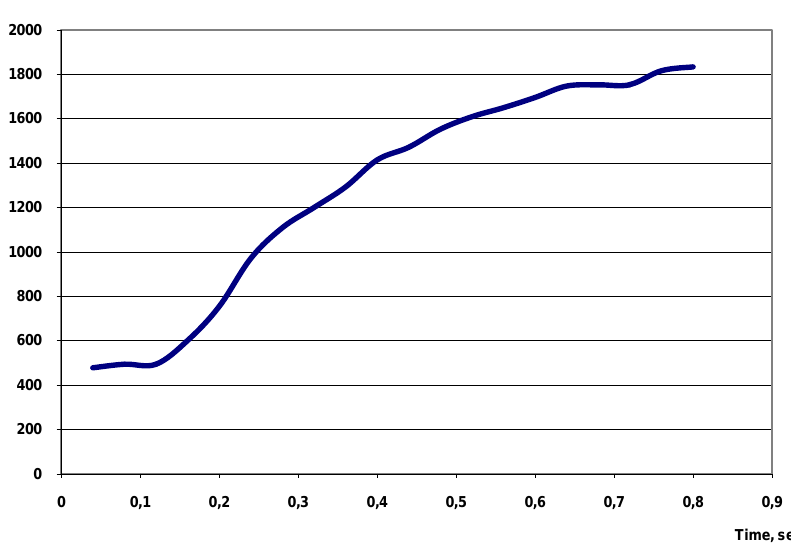
Diagram 4. Snatch trajectory with weight 65% from maximum. Apparatus- separate